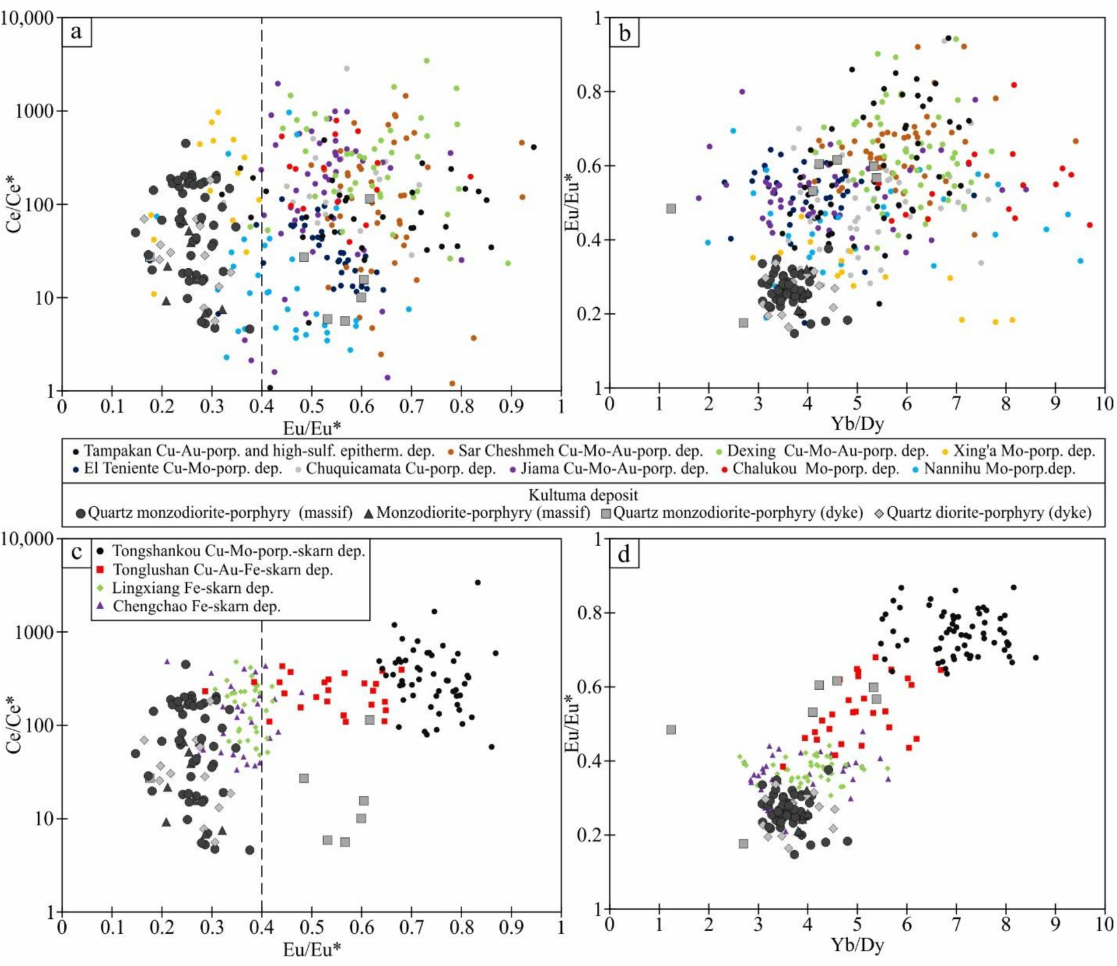
Figure 21. Plot of zircon ( a , c ) Ce/Ce* versus Eu/Eu*; ( b , d ) Eu/Eu* versus